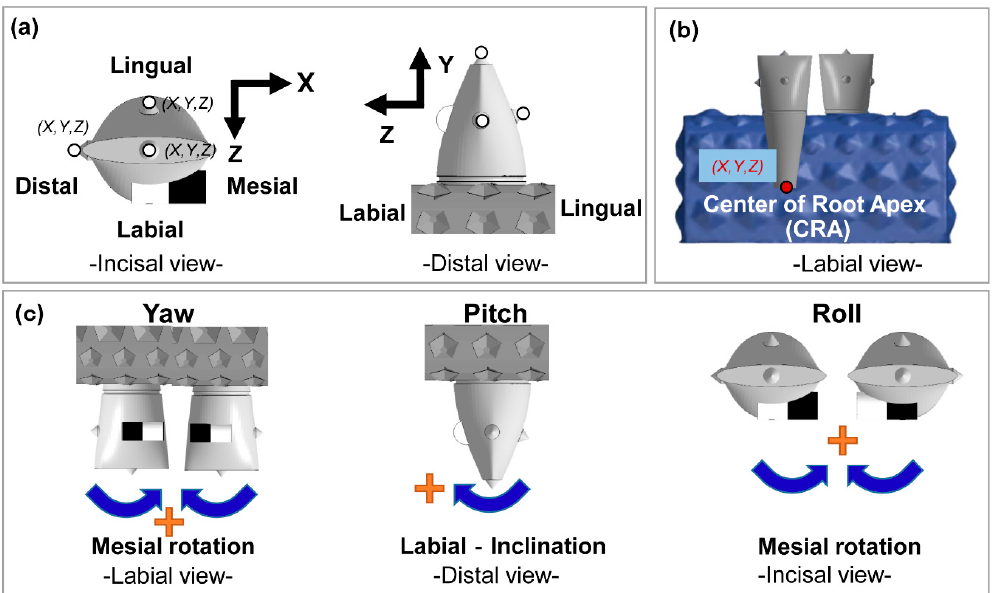
Figure 3. Scheme of tooth movements and rotations. ( a ) X, Y, and Z ‐ axis direction of tooth movement, ( b ) identification of the center of root apex CRA). ( c ) rotations: yaw, pitch, and roll.